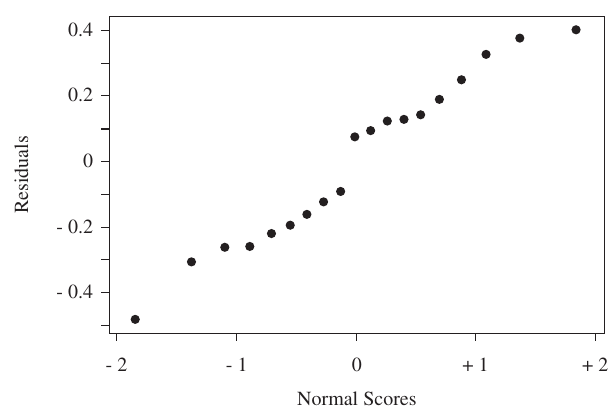
Figure 8. Graph of residuals against normal scores for rolled notch testpieces (after applying logarithmic